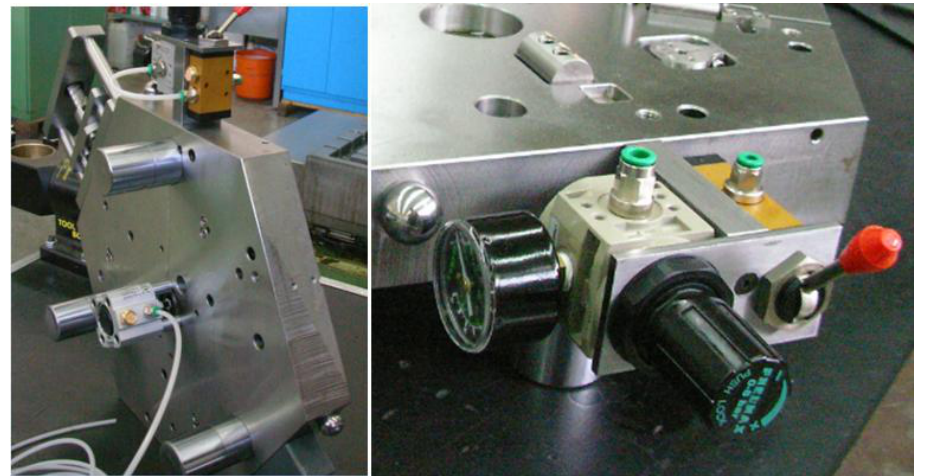
Figure 12. Pneumatic system to generate the kinematic coupling preload.